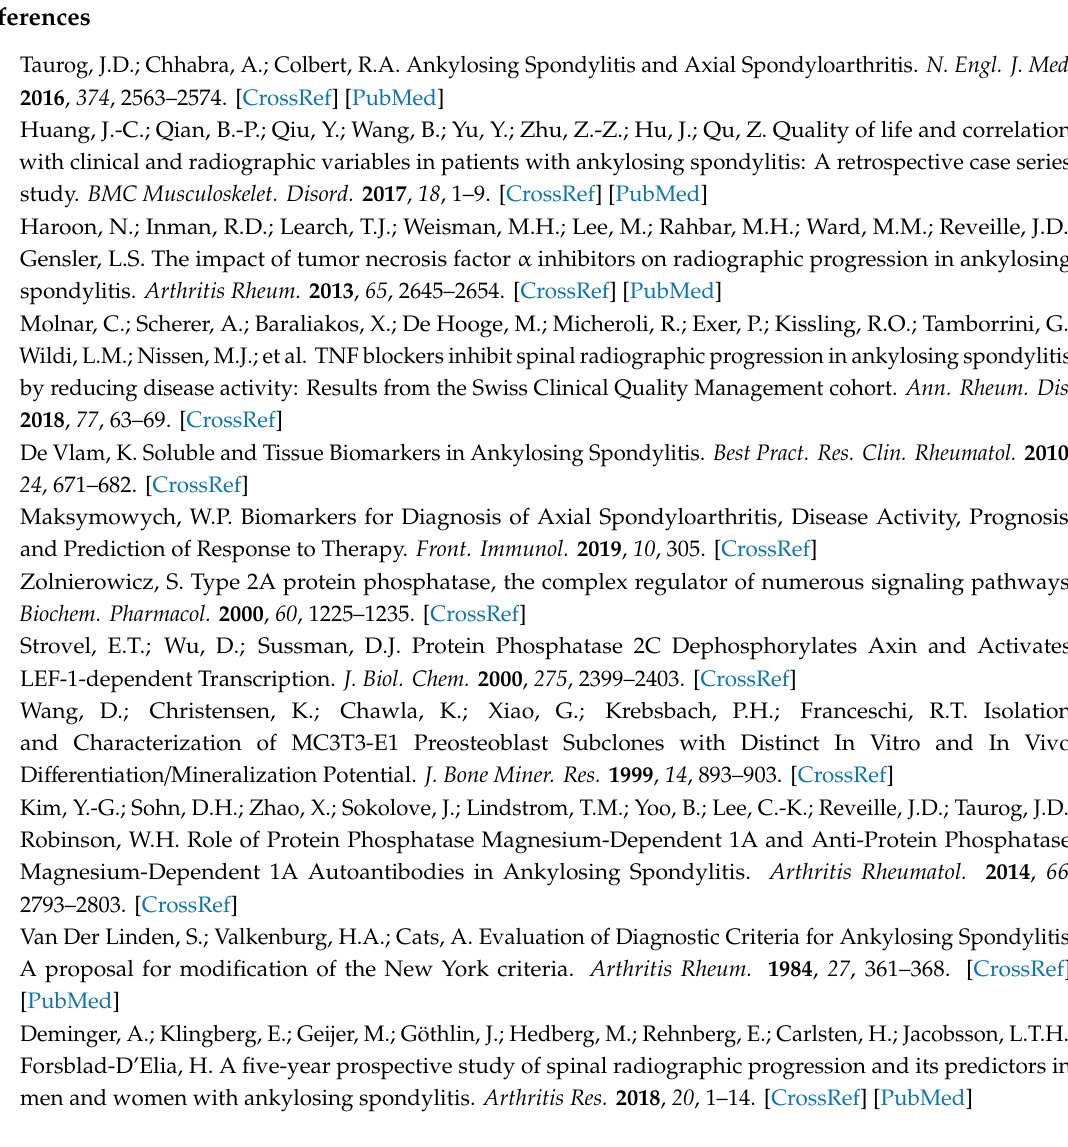
Figure S1: ROC analysis according to sex predicting radiographic progression in AS patients treated with anti-TNF agents with regards to anti-PPM1A